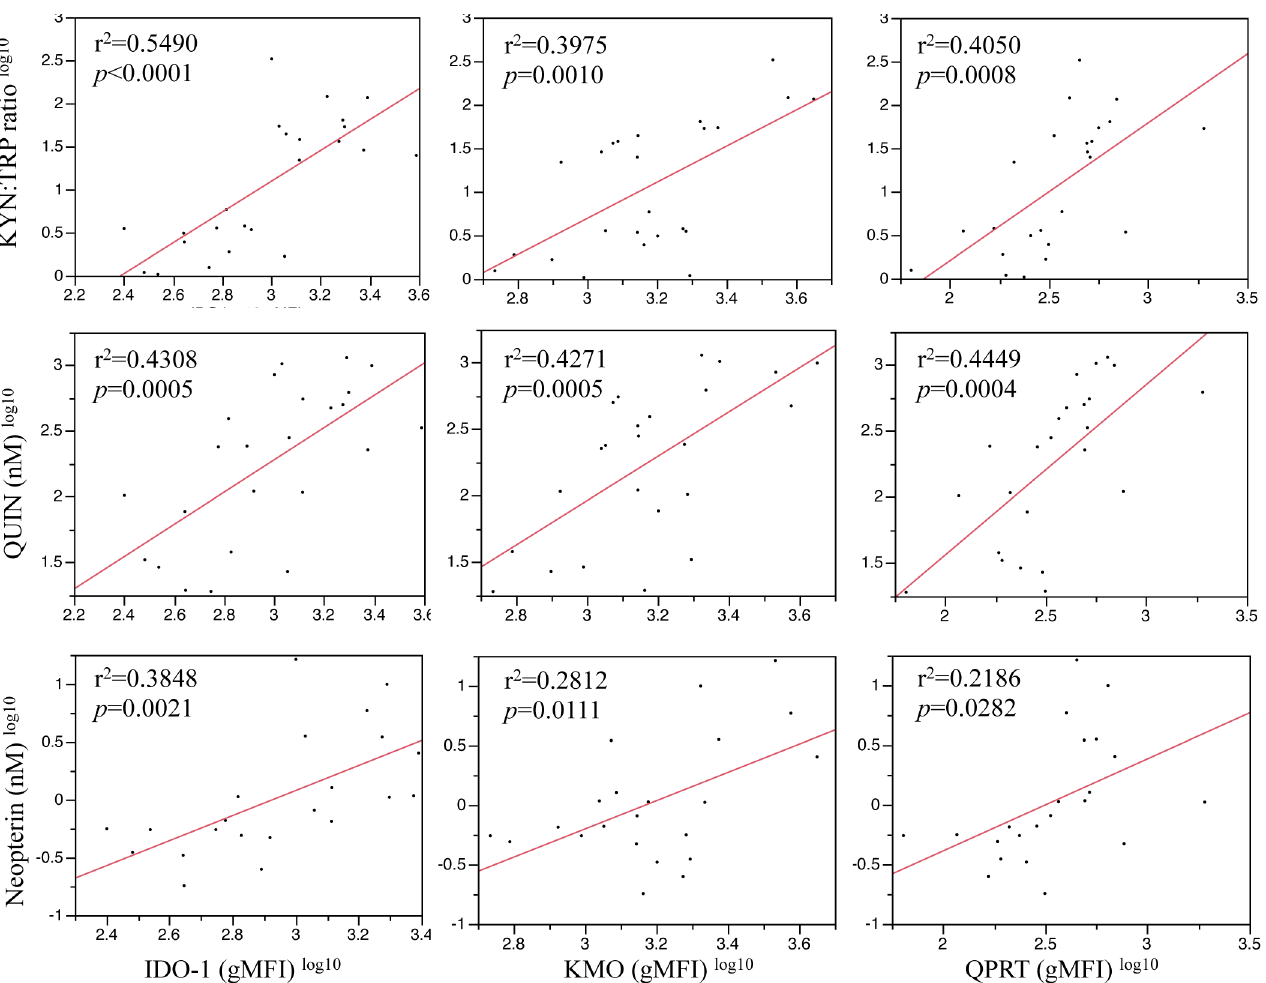
Fig 5. Correlations of IDO-1, KMO and QPRT expression (gMFI) with KYN:TRP ratio, QUIN concentration (nM) and neopterin levels (nM). Data was log 10 transformed to normalize distributions. Straight-line fits show least squares regression with the r 2 value providing a summary of fit. P values were computed using ANOVA for a regression analysis of the total variation for each correlation (n =